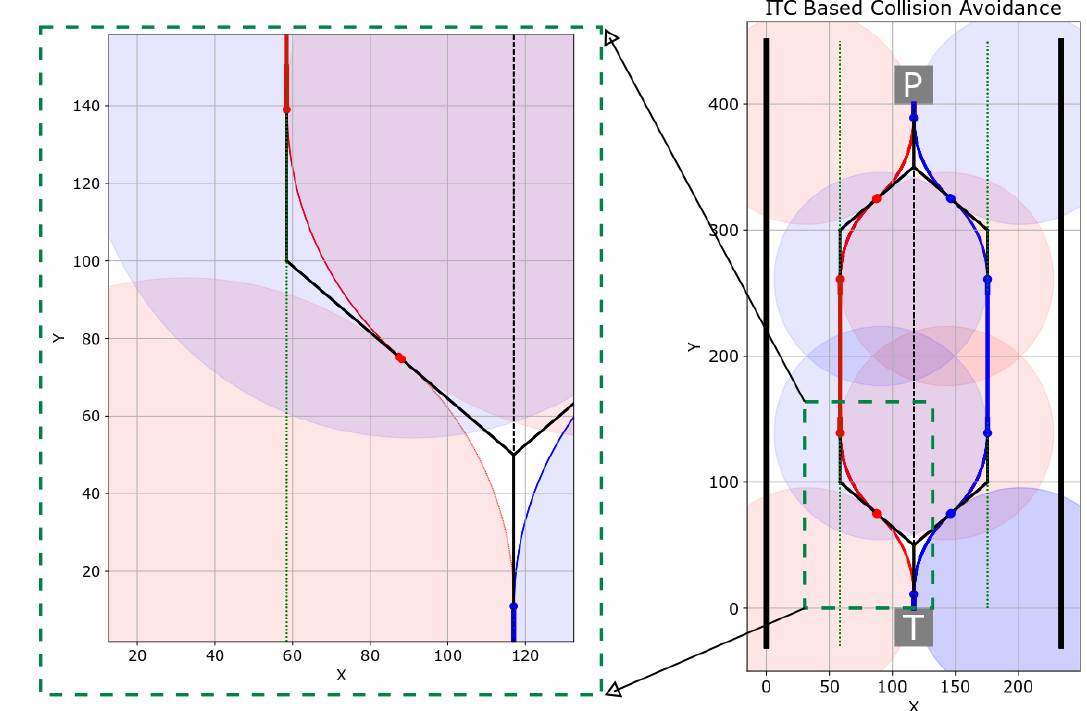
Figure 20. Trajectories of the two robots. Pioneer P3DX and Turtlebot are marked as P and T, respectively. The parameters were set as ψ 1 = ψ 2 =